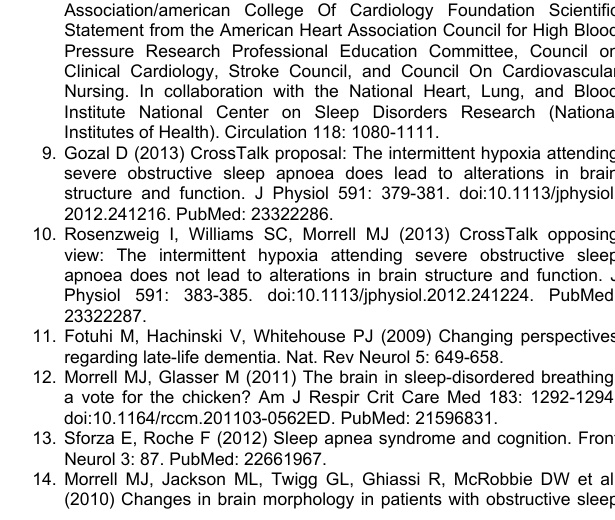
Table S1. Percentage Ratios of Subcortical Volumes to the ICV as determined by FreeSurfer.